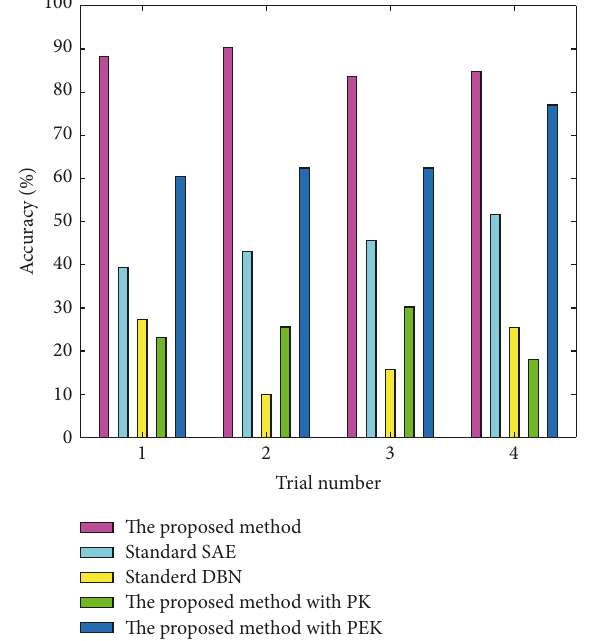
Figure 5: Detailed diagnosis results of the 4 trials in Experiment 1.